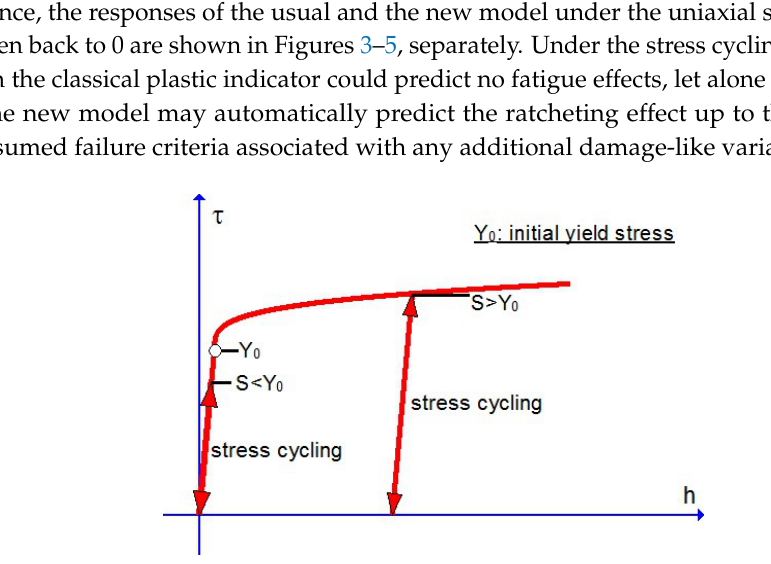
Figure 3. Responses of the usual model with the classical plastic indicator under the uniaxial stress cycling from 0 to S and then back to 0 keep the same for both S < Y 0 and S > Y 0 .